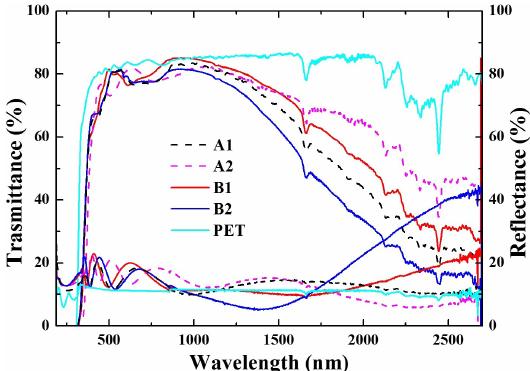
Figure 1. Optical transmittance and reflectance spectra of the PET substrate and the AZO/PET samples described in Table Table 1. Type of supply, target-substrate distance, thickness, optical transmittance and electrical resistivity of the samples studied. Sample